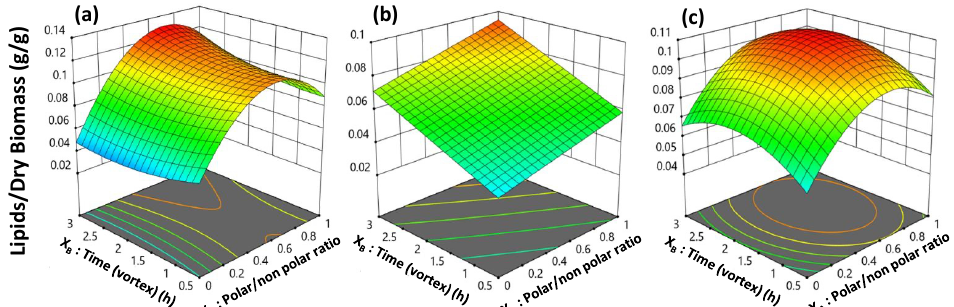
Figure 3. Response surface plots for L/DB response for three types of solvents, ( a ) MeOH/Hex (dry biomass/solvent ratio = 40); ( b ) Isop/Hex (dry biomass/solvent ratio = 10); and ( c ) MeOH/AcOEt (dry biomass/solvent ratio = 10), as a function of polar/non-polar ratio (X A ) and vortex time (X B ).